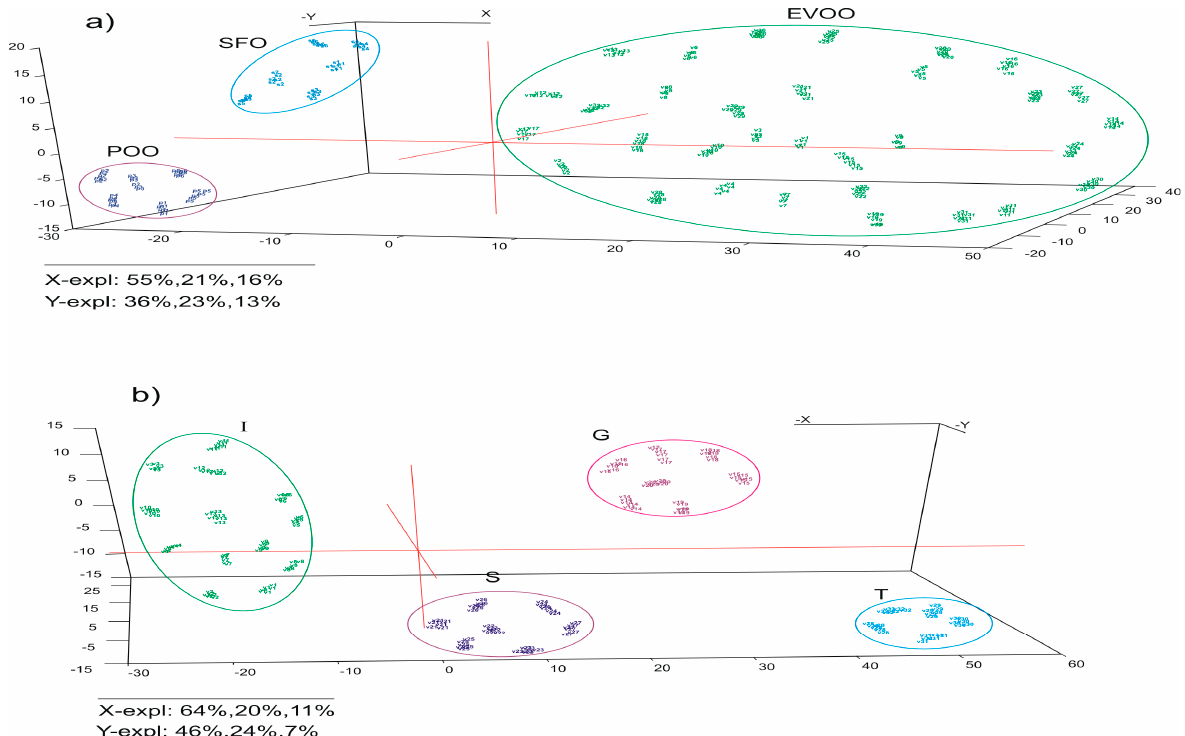
Figure 6. PLS-DA scores plot resulting from the sensor data (X matrix) corresponding to different classes of oils (Y matrix): ( a ) EVOO, POO and SFO samples; ( b ) Italy, Spain, Greece and Tunisia EVOO samples.